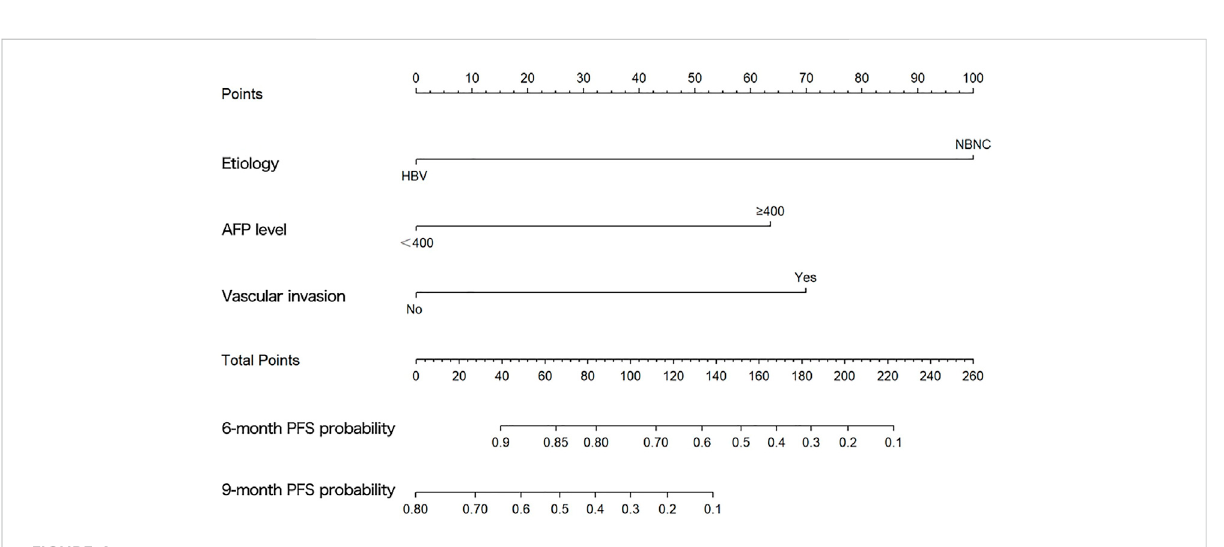
FIGURE 4 Graph showing the prognostic model for predicting 6- and 9-months progression-free